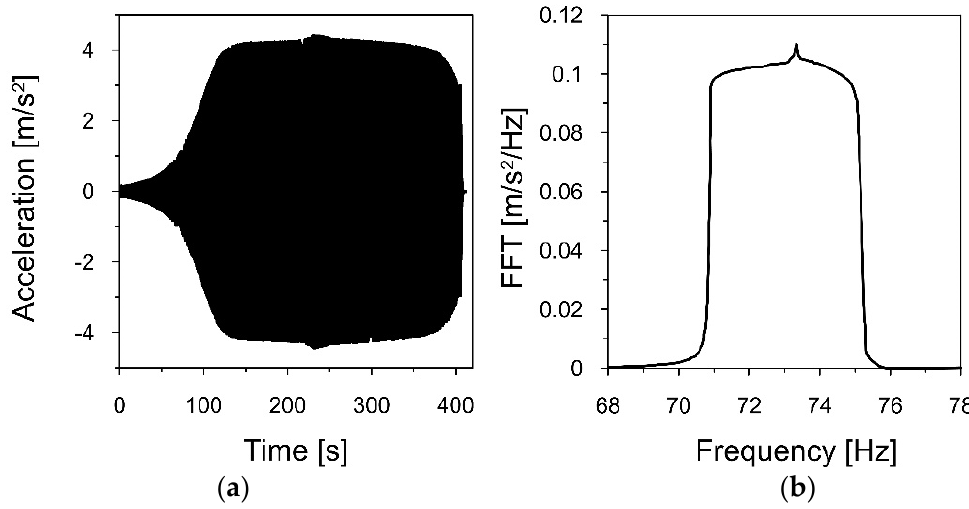
Figure 16. ( a ) The acceleration − time history of the model vibrations, caused by a linear sweep in the range of 71–75 Hz, registered at the top of the model; ( b ) the Fourier spectrum of the signal.